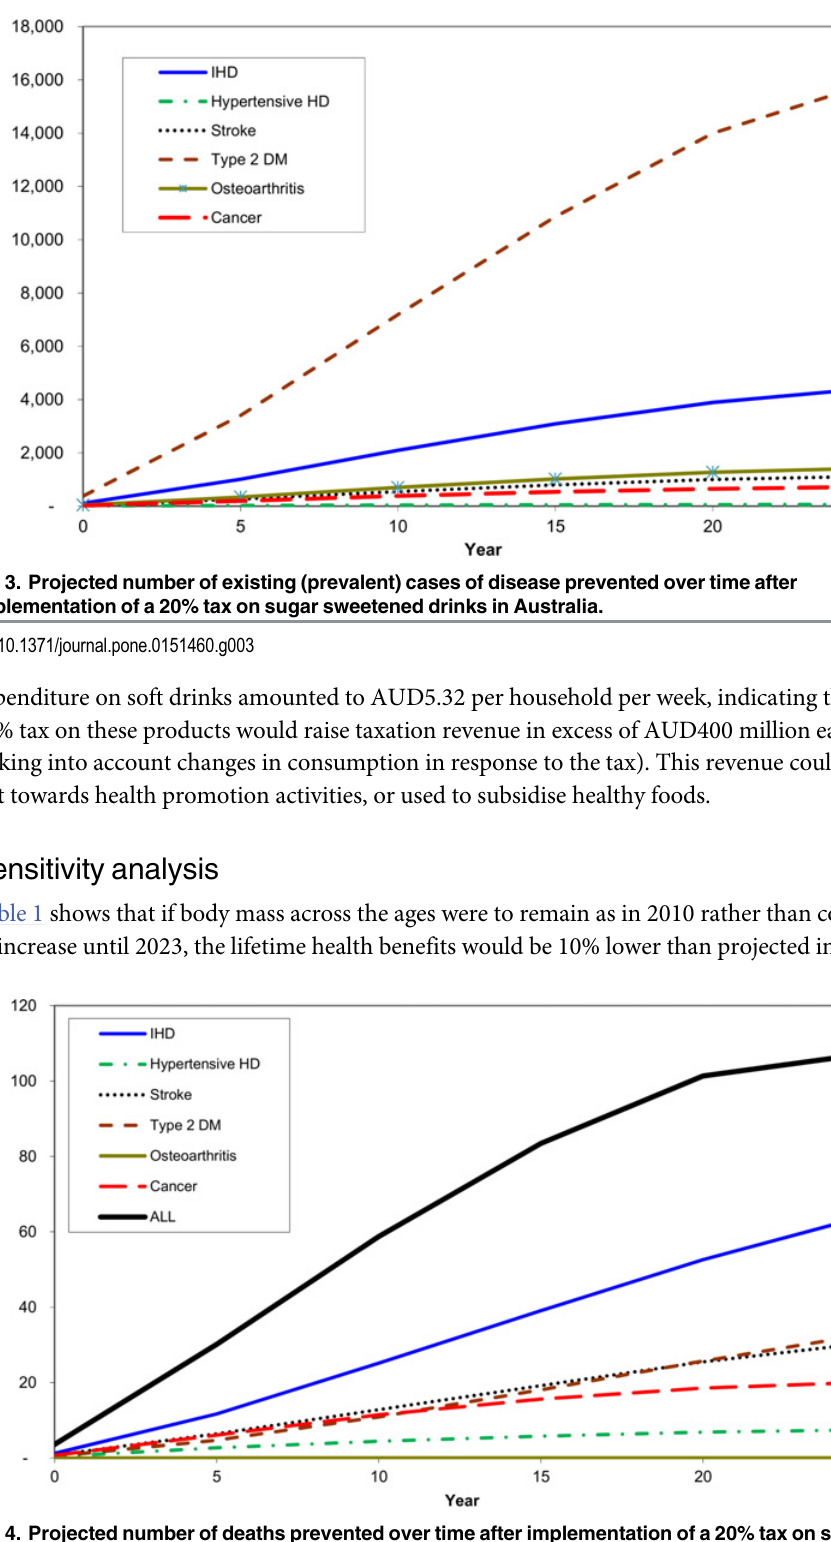
Fig 4. Projected number of deaths prevented over time after implementation of a 20% tax on sugar sweetened drinks in Australia, by cause of death.